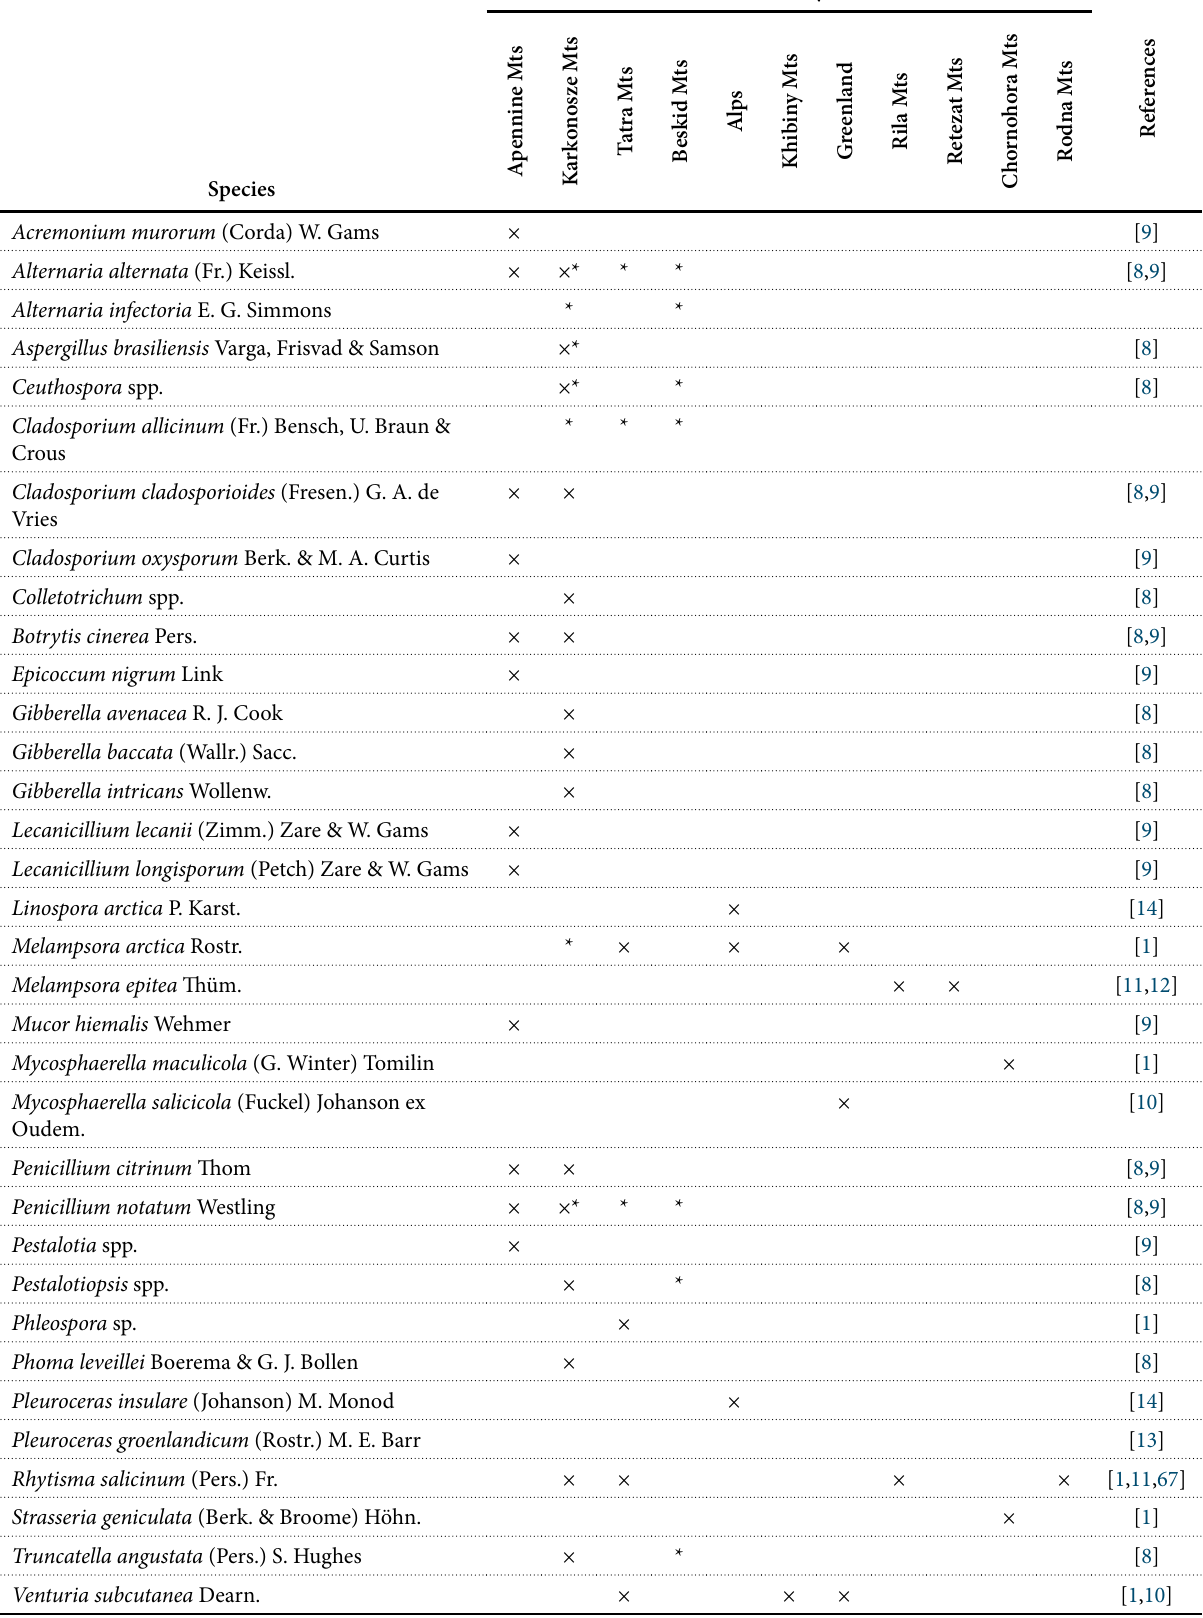
Tab. 5 Fungi species reported on S. herbacea based on own observations and literature